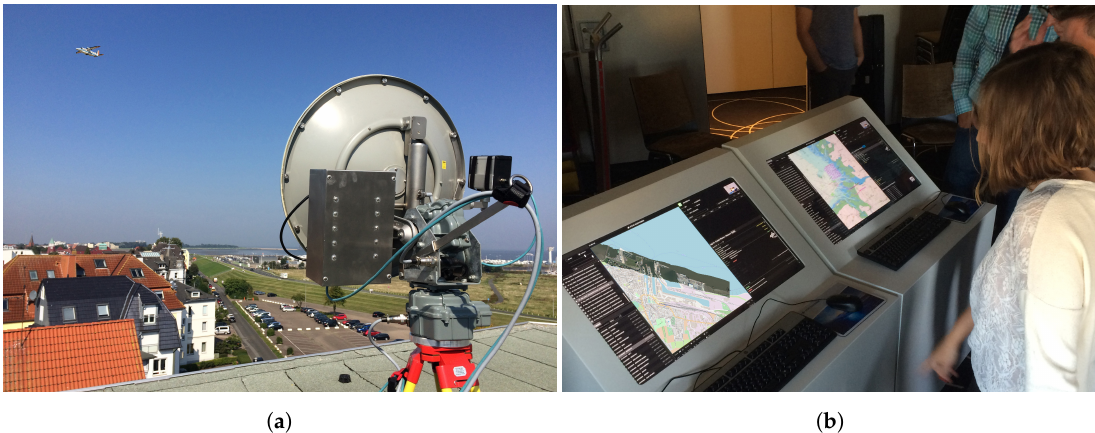
Figure 12. Aircraft-based demonstration of real-time aerial mapping: ( a ) aircraft with DLR Modular Airborne Camera System (MACS) and WiFi-based 10 Mbit/s data downlink; and ( b ) generation of seamless aerial maps from the transmitted image data in real-time. The latency between image acquisition and visualization is about 2